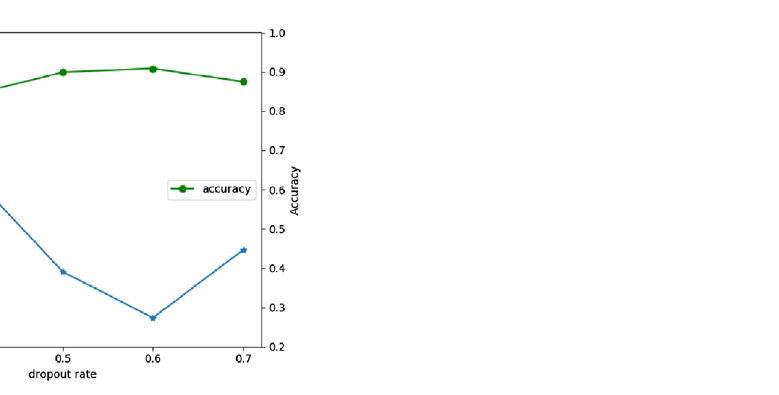
Figure 10. The accuracy and loss comparation with different dropout